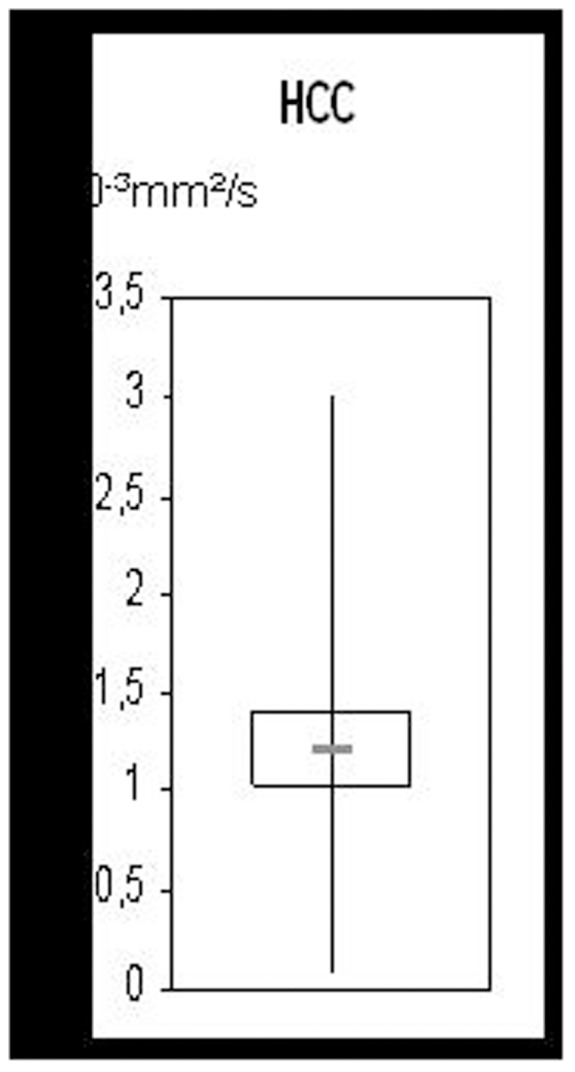
Range of ADC-values (10−3 mm2/s) in lesions suspicious for HCC.